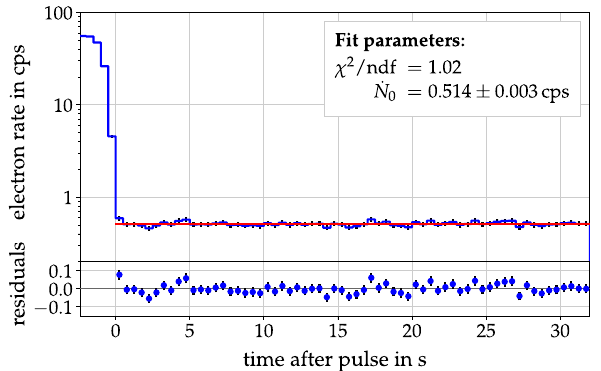
Fig. 7 Effectofthemagneticpulseontheremainingbackgroundwith- out artificial sources. The pulse was applied every 35 s by inverting LFCScoilsL1–L13for1 satanominalmagneticfield B min = 0 . 38 mT. The plot shows the averaged electron rate from n = 1544 pulse cycles aligned by the reference signal. The electron rate between the pulse cycles is fit by a linear model. In contrast to Fig. 6 no background reduction is observed, although the visible “pulse spike” indicates that magnetic pulses are